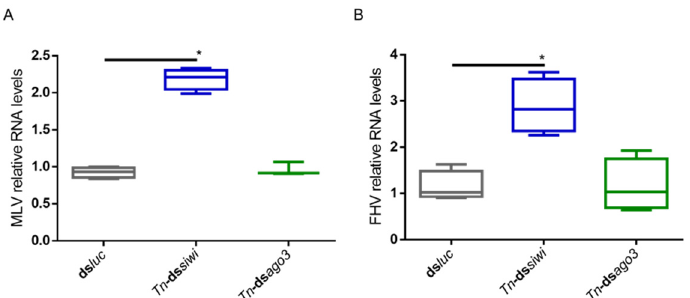
Figure 2. Relative RNA levels of B. mori Macula-like Latent Virus (MLV) and Flock House Virus (FHV) in High Five cells upon Siwi and Ago3 knockdown. High Five cells were transfected with Tn -ds siwi , Tn -ds ago3 or ds luc (negative control). The graphs depict MLV ( A ) and FHV ( B ) relative RNA levels, measured by qRT-PCR on day 3 post-transfection. Each box depicts the interquartile range, with the inner line representing the median. The whiskers represent the minimum and maximum values. Statistical analysis (Mann–Whitney test) was performed in GraphPad Prism 6 (* p < 0.05; ( A ) n ≥ 3; ( B ) n = 4).